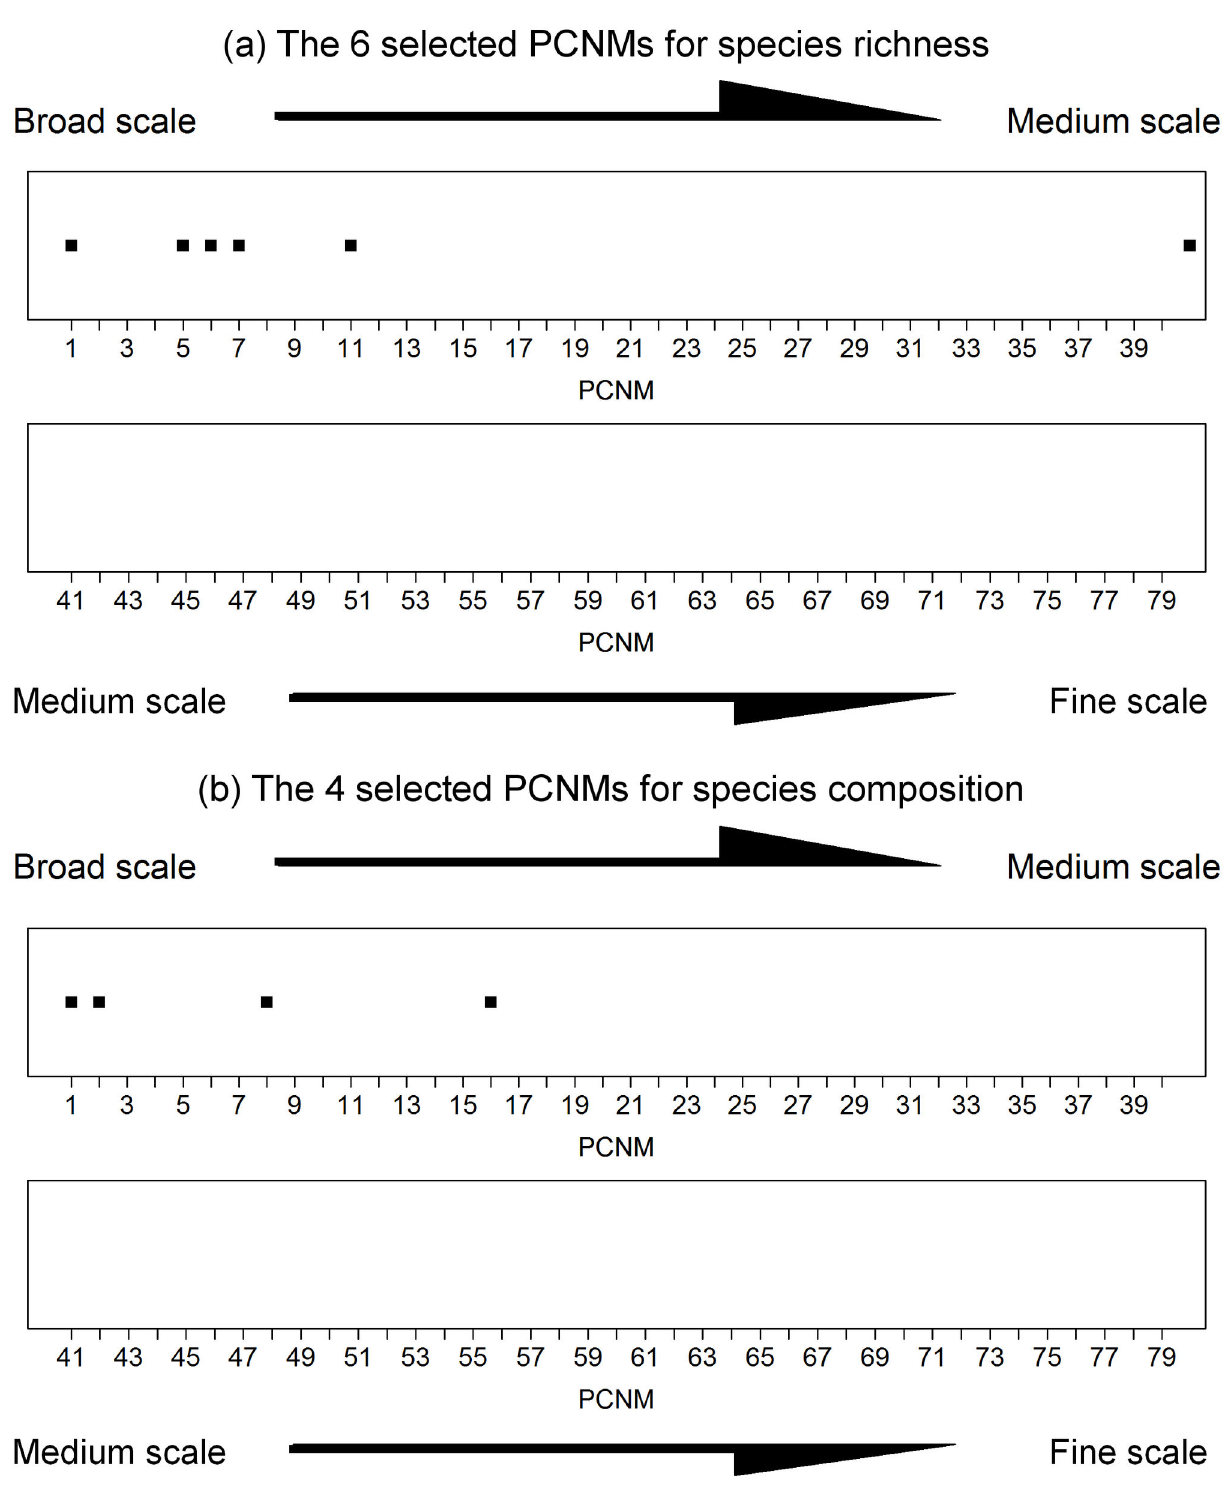
Figure 4. Selected PCNMs from the 79 PCNMs that exhibit a positive spatial correlation for the richness and composition of all species. The PCNMs are represented by square dots.